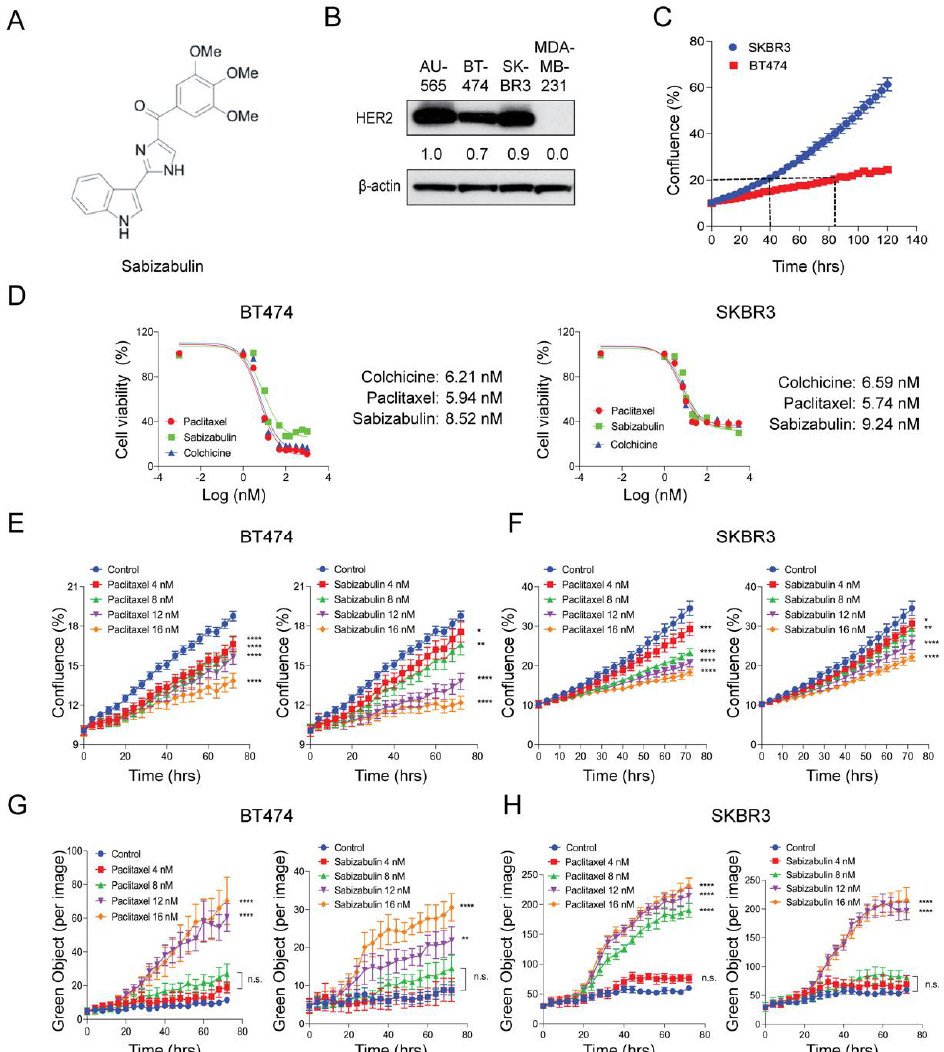
Figure 1. Effect of sabizabulin, colchicine, or paclitaxel in BT474 and SKBR3 HER2+ cell lines. ( A ) Chemical structure of sabizabulin. ( B ) Levels of HER2 in breast cancer cell lines were determined by western blotting; β-actin serves as a loading control. Signal intensity was evaluated by ImageJ densitometry with the AU565 sample set to 1.0. ( C ) Proliferation assay over time (120 h) using BT474 and SKBR3 cells to determine doubling times by confluence (%) using the IncuCyte S3 instrument (5000 cells/96-well; n = 4 wells/cell line). ( D ) The growth inhibition effect of sabizabulin relative to colchicine or paclitaxel was determined by MTS assay after 72 h or 96 h (SKBR3 or BT474, respectively) over a range of concentrations (0.3 nM to 3.0 µ M, on a log (nM) scale) and expressed as cell viability (%)representative response curves of three independent biological replicates are shown. ( E , F ) Growth inhibition assays for BT474 cells ( E ) or SKBR3 cells ( F ) treated with paclitaxel or sabizabulin at increasing concentrations as measured by confluence (%) over time (hrs). ( G , H ) Evaluation of time- and concentration-dependent cytotoxicity for BT474 ( G ) and SKBR3 ( H ) cells as enumerated by Cytotox Green reagent counts (Green Object per image) over time (hrs).All p -values are shown as pairwise comparisons to the vehicle (control) group; * p < 0.05; ** p < 0.01, *** p < 0.001, **** p < 0.0001; n.s., not